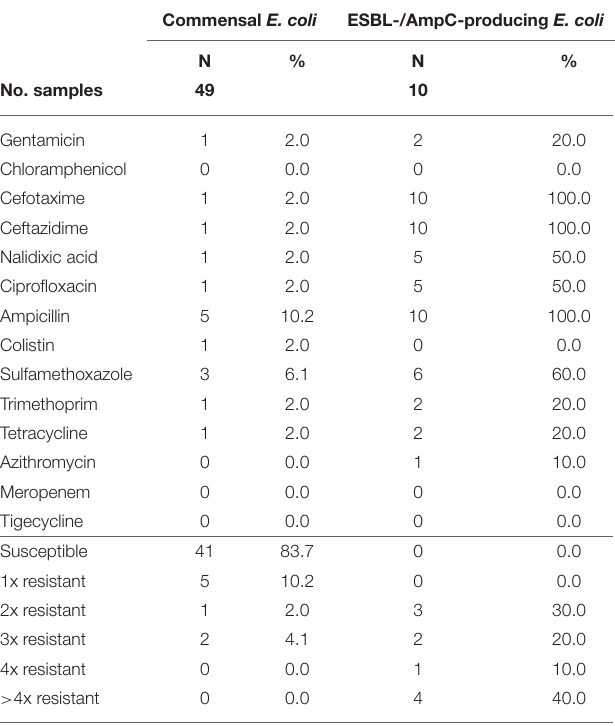
TABLE 7 | Number and proportion of tested resistant isolates from wild ducks and geese and the number of substance classes to which the isolates were resistant. Commensal E.